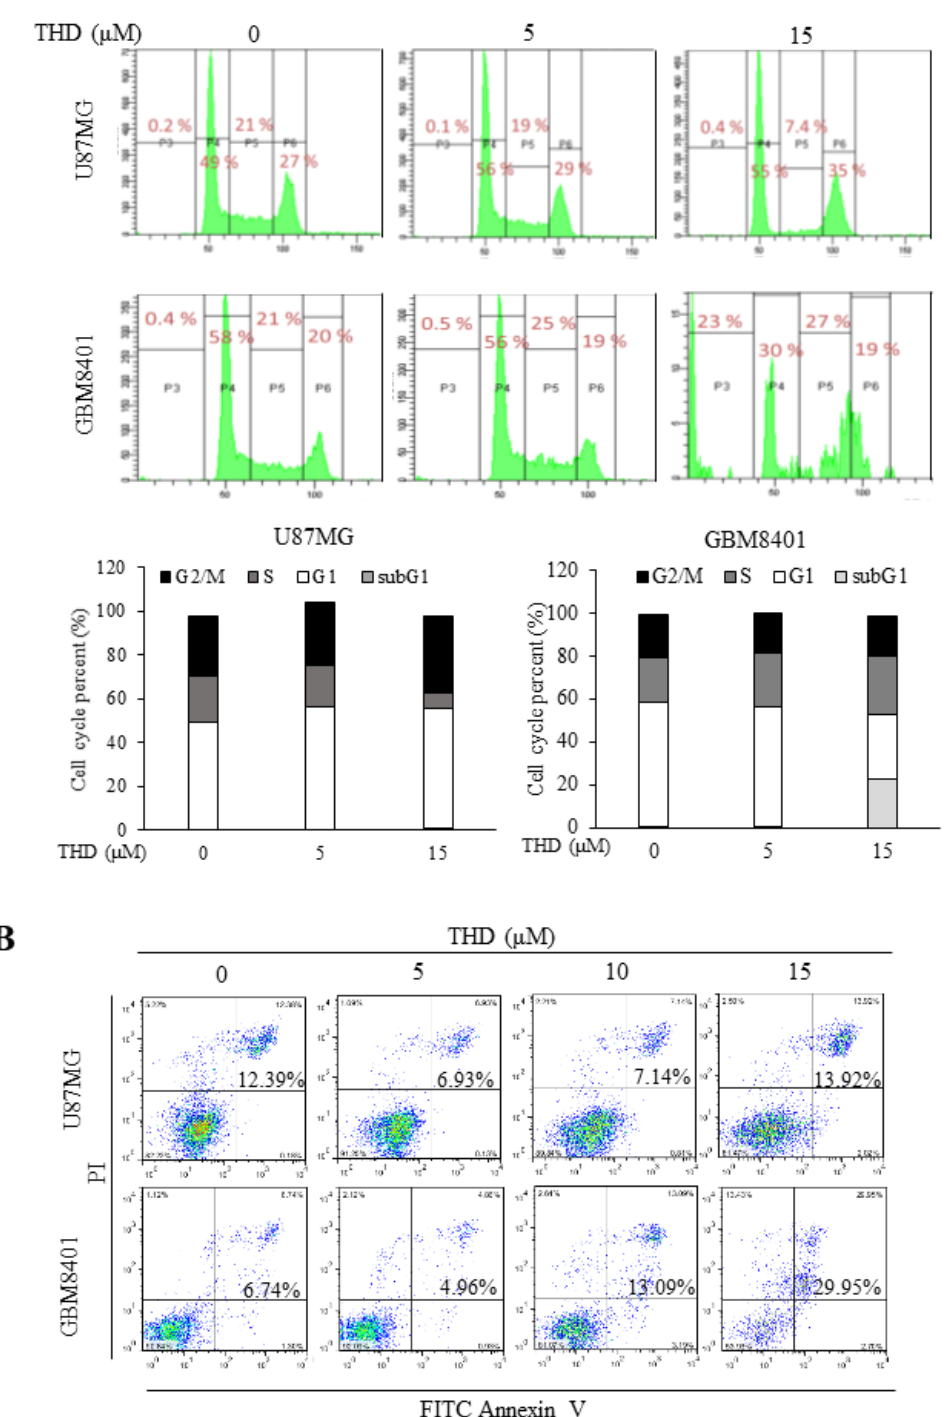
Figure 2. THD induced cell apoptosis in GBM cells. ( A ) U87MG and GBM8401 cells were treated with THD at 5 or 15 µ M for 24 h, and cell cycle alterations were quantified through flow cytometry with staining with 50 µ g/mL PI; ( B ) U87MG and GBM8401 cells were treated with THD at 5, 10, or 15 µ M for 24 h, and the apoptotic cell percentage was quantified through flow cytometry by using the FITC Annexin V Apoptosis Detection Kit (BD PharmingenTM, cat. 556547). Representative scatter plots of PI (y-axis) versus annexin V (x-axis).